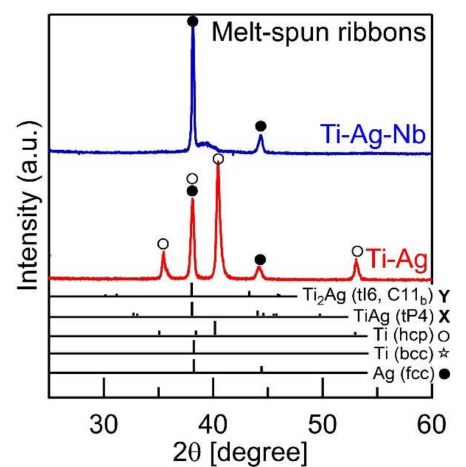
Figure 8. XRD patterns of the rapidly-solidified melt-spun ribbons in the Ti 66.7 Ag 33.3 (Ti-Ag, red color, lower side) and Ti 53.4 Ag 33.3 Nb 13.3 (Ti-Nb-Ag, blue color, upper side)